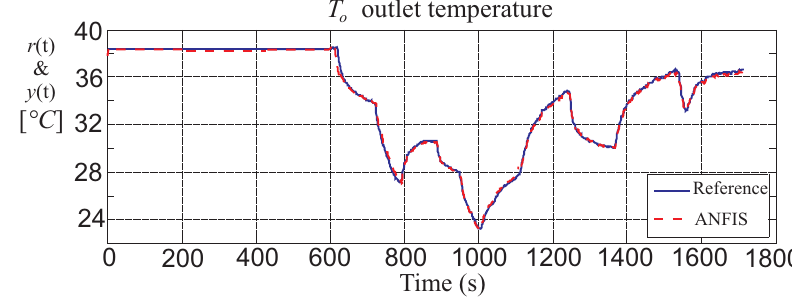
Figure 6. Diagram of the TU simulated model with the Adaptive Neuro-Fuzzy Inference System (ANFIS) fuzzy regulator.